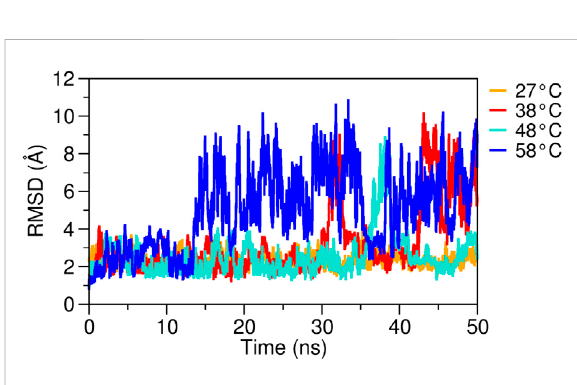
FIGURE 6 RMSD plots of the eugenol – β -cyclodextrin complex